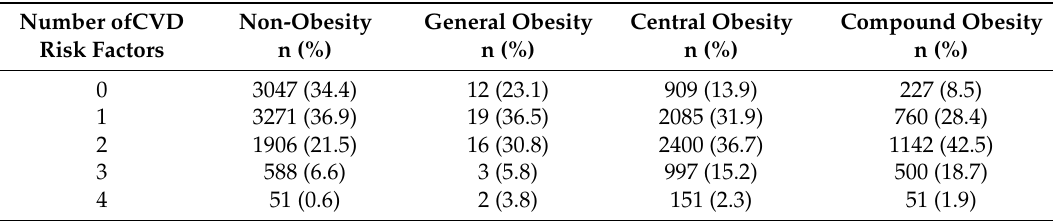
Table 4. Distribution of the number of CVD risk factors in different types of